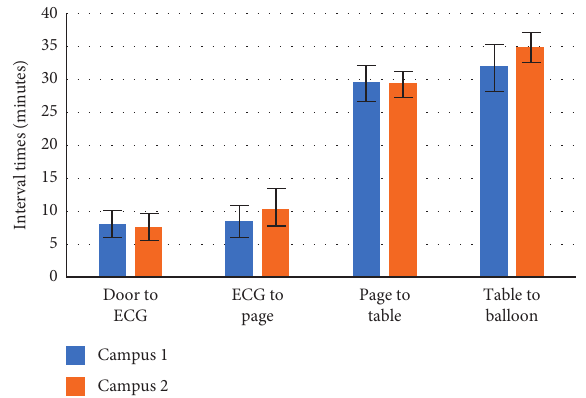
Page to table Table to Balloon Times are reported as hours:minutes.